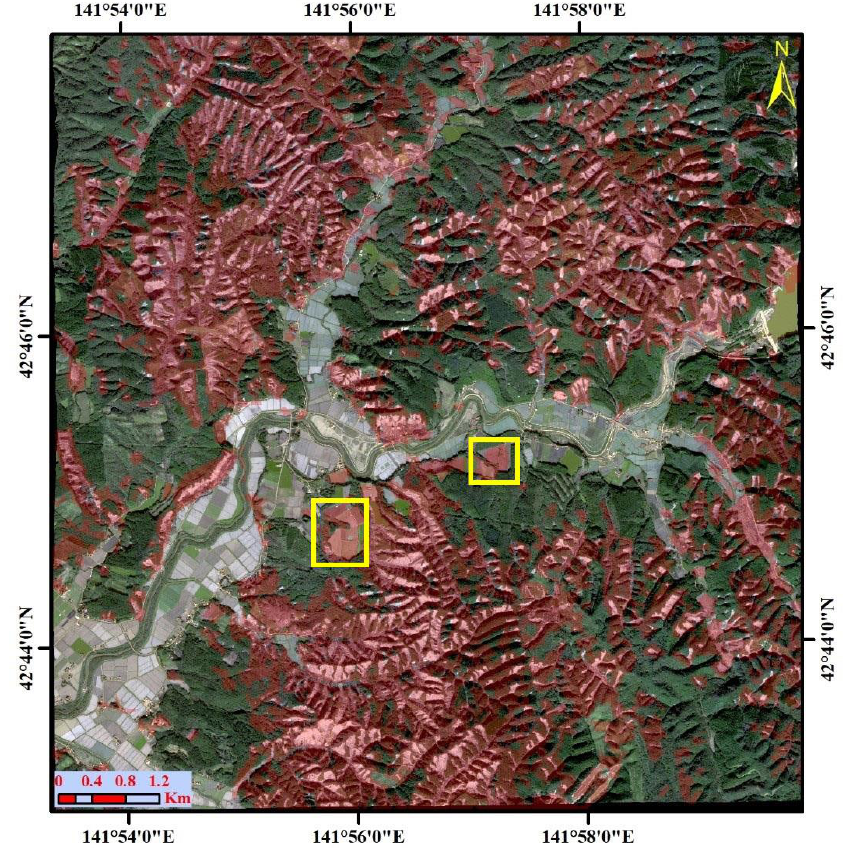
Figure 14. The landslide classification map using coherence and intensity di ff erences from both descending and ascending SAR pairs (case 6). The background is a GeoEye-1 image taken on 20 October 2018.